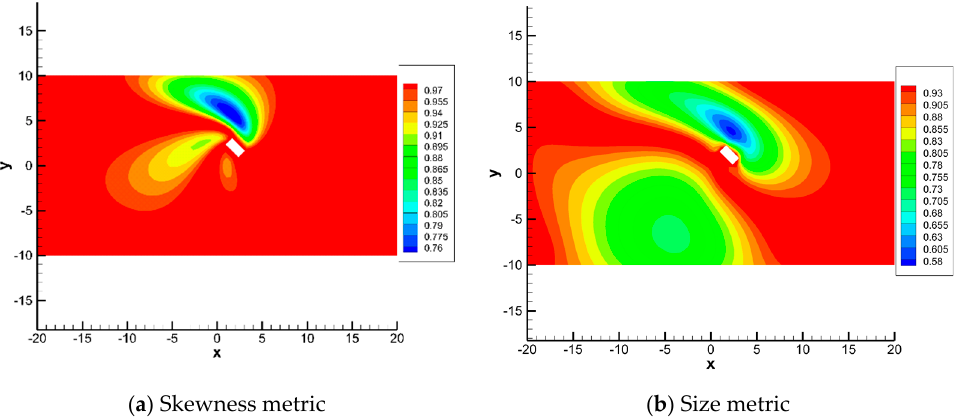
( b ) Deformed mesh Figure 2. Mesh of test case 1.